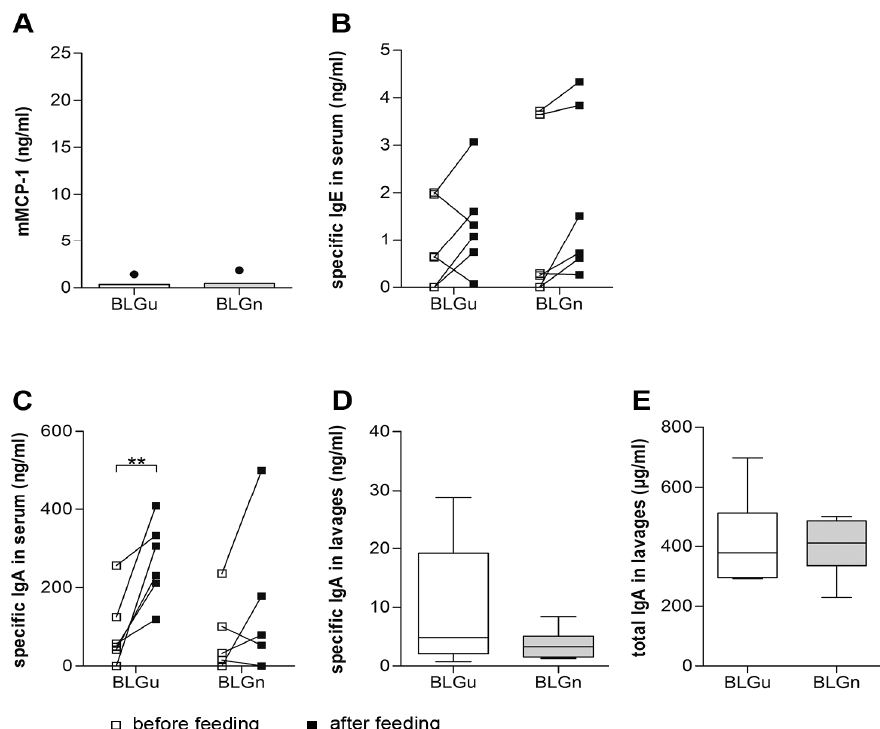
Figure 3. Immune response to oral gavages in non-allergic mice. ( A ) Serum collected 1 h after the last gavage did not show significant levels of mMCP-1. ( B ) Serum samples collected before and after oral gavages of BLGu and BLGn were analyzed. Neither BLGu (paired t -test) nor BLGn (Wilcoxon signed-rank test) induced significant production of IgE in the serum of previously non-allergic mice after three oral gavages. ( C ) BLGu elicited a significant elevation of specific IgA in serum (paired t -test). ( D ) Differences of specific IgA in lavages did not reach statistical significance between groups (unpaired t -test with Welch correction) ( E ) Total IgA in lavages did not differ comparing both groups after gavages (unpaired t -test). ** p < 0.01; BLG, beta-lactoglobulin; BLGn, nitrated BLG; BLGu, untreated BLG, mMCP-1 mouse mast cell protease-1. Table 2. Relative and absolute Treg counts from spleens and pooled lymph node cells of non-allergic or allergic animals after gavages of BLGu or BLGn.